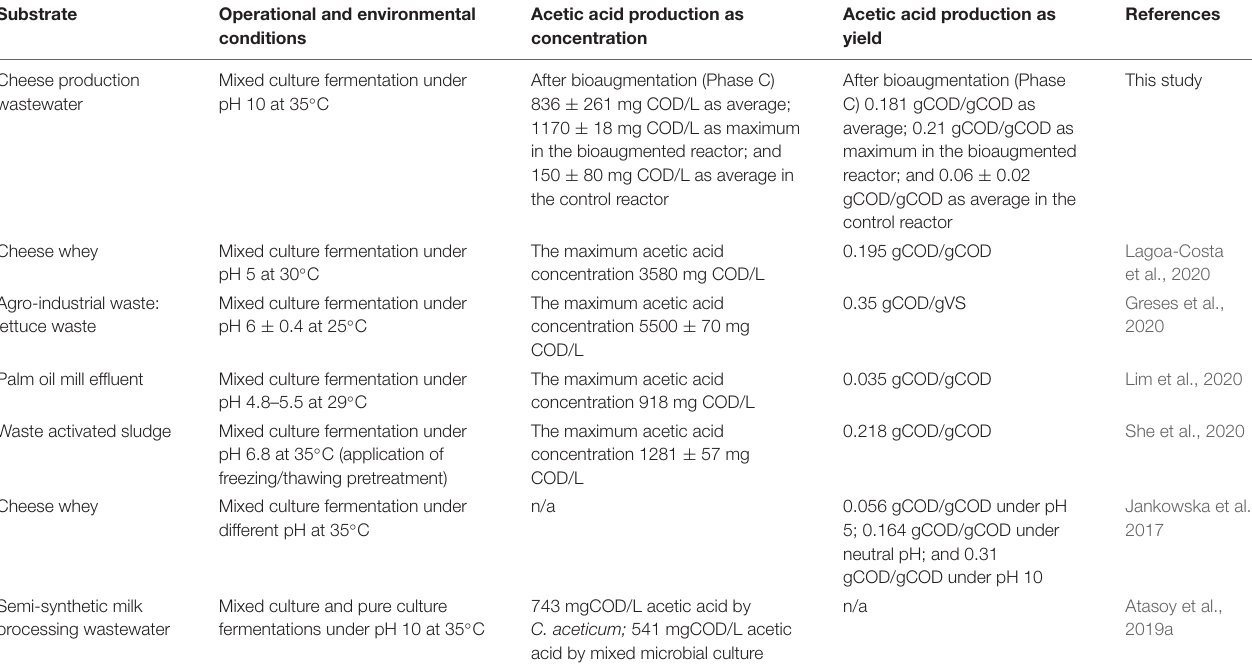
TABLE 1 | Acetic acid production by mixed microbial culture fermentation under various operational and environmental